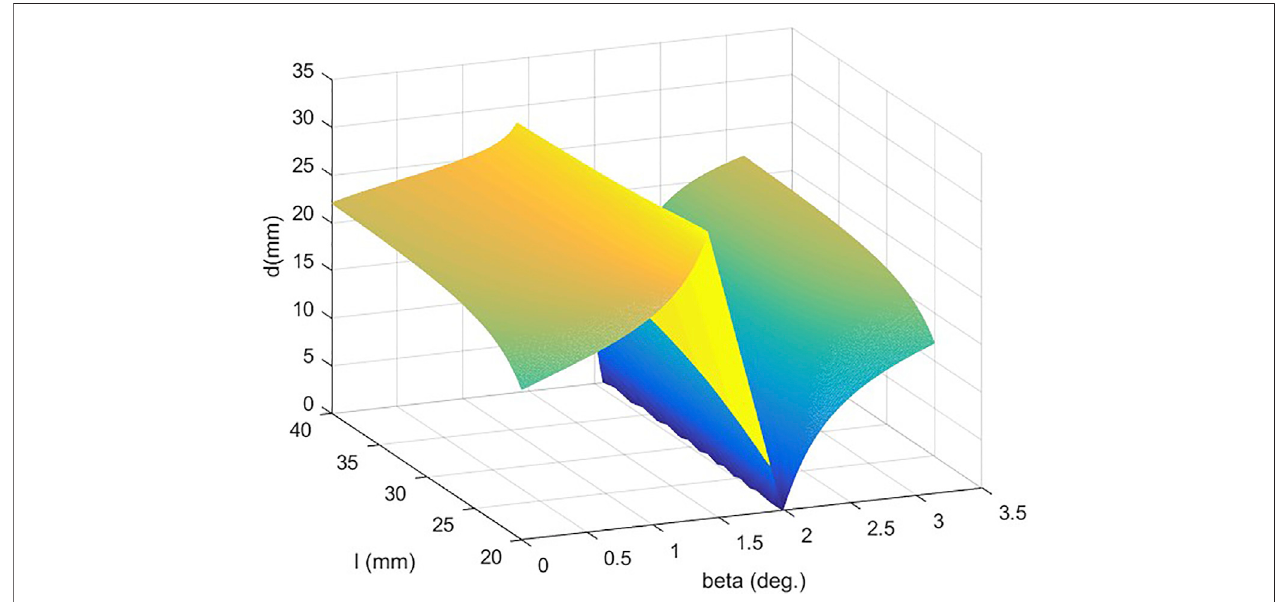
FIGURE 6 | Moment arm at the contact point.